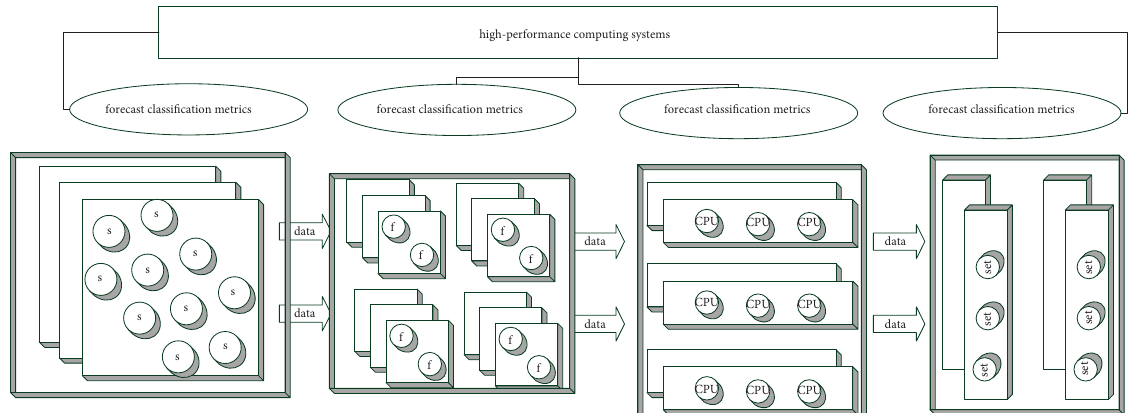
Figure 3: Marketing forecast classification measurement